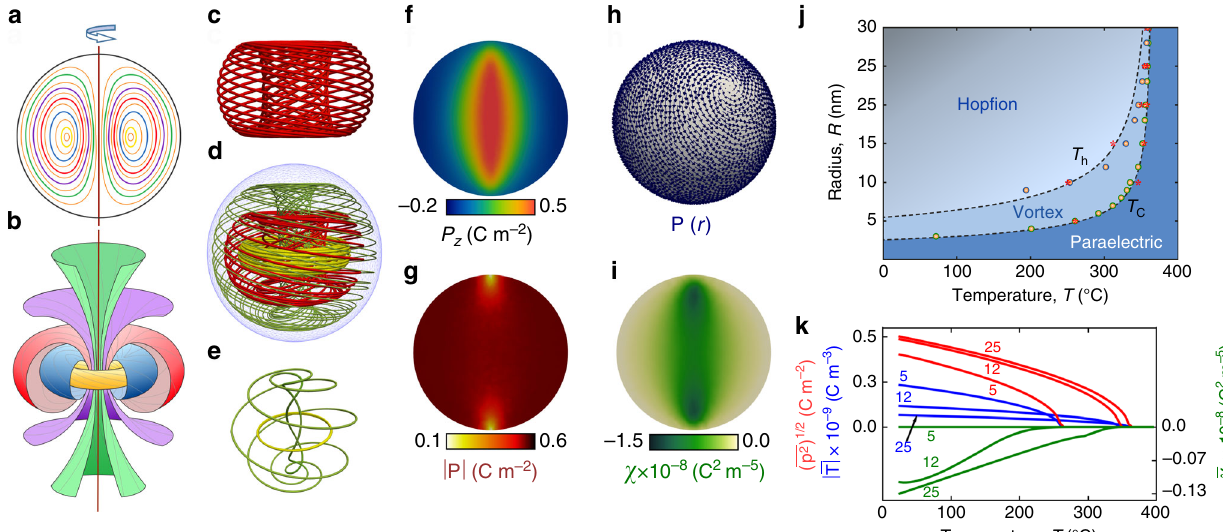
Fig. 2 The Hop fi on structure. a A cross section of the spherical nanoparticle exposing a cut across the set of nested concentric tori. b The set of tori obtained by rotation of the loops shown in a around the vertical axis. Each torus is entwined by a dense set of the polarization lines 49 . c A single Hop fi on torus wrapped up by polarization lines calculated in the framework of the isotropic model. d Three nested tori entwined by the polarization lines illustrating their tendency to densely fi ll up the nanoparticle. e Exemplary polarization lines belonging in the tori shown in d that illustrate linking of the loops in the Hop fi on. f The color map of the P z − component of the polarization over the meridian cross section of the nanoparticle. g , The color map of the distribution of the amplitude of the polarization, ∣ P ∣ . h Whirlpool distribution of the polarization over the surface of the nanoparticle near the Hop fi on axis. i , The color map of the chirality, χ , distribution inside the nanoparticle. j The temperature-radius, T – R , phase diagram of the Hop fi on and vortex topological states in the isotropic spherical nanoparticle. The circles display results of numerical computations of the paraelectric-vortex, T c , and vortex-Hop fi on, T h , transition temperatures. The dashed lines correspond to the geometrical scaling fi t, see text. Importantly, the vortex phase occupies a very narrow region in the vicinity of the paraelectric-ferroelectric transition and the dominant part of the phase diagram corresponds to the Hop fi on state. The color gradient re fl ects emergence of the chirality. The red asterisk symbols stand for the transitions in the anisotropic ferroelectric PZT nanoparticle. k The temperature 1 = 2 dependencies of the ferroelectric characteristics, mean-squared polarization, ð P 2 Þ , (blue lines), the absolute value of the mean toroidal moment, j T j , (red lines), and the mean chirality χ (green lines), taken for three representative nanoparticle radii, R = 5, 12, and 25